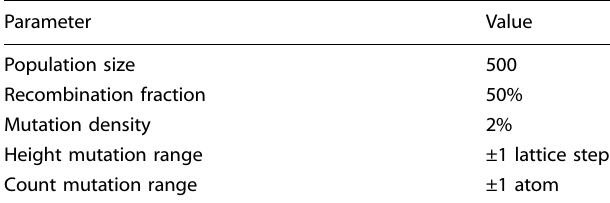
Table 1. Genetic algorithm